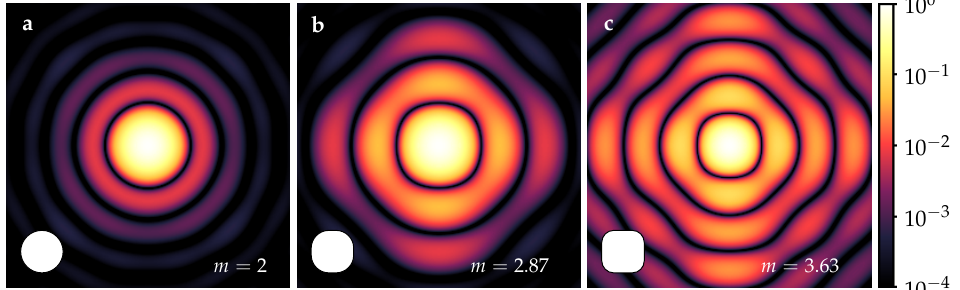
Figure 6. Numerically calculated form factors of the ( a ) solid spherical, ( b ) hollow semi-cubic and ( c ) hollow cube-like superballs at a rotation of φ = 0°. The orientation of the superball particles is depicted in the insets of the images. Here, the intensity is limited to 4 orders of magnitude, which is approximately the same range the detector used in these experiments is able to